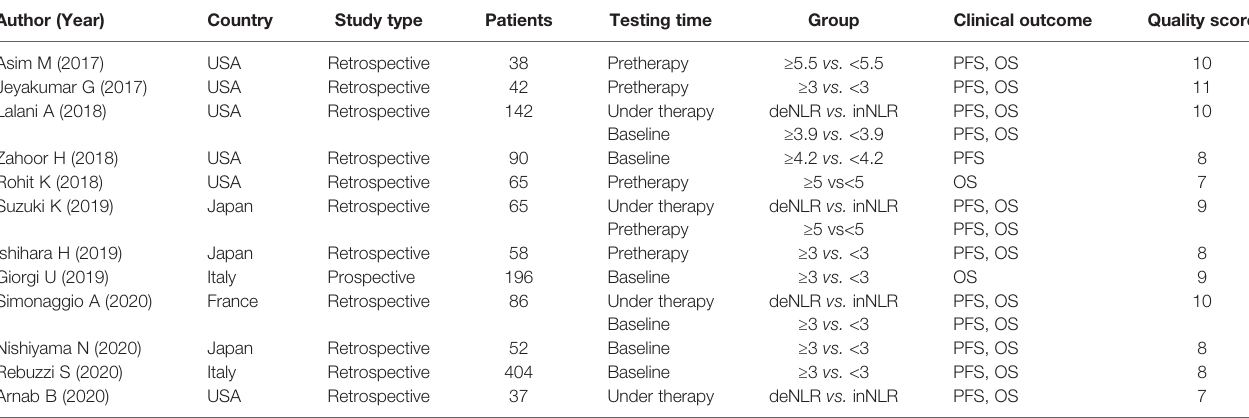
TABLE 1 | Study features of the 12 eligible records.